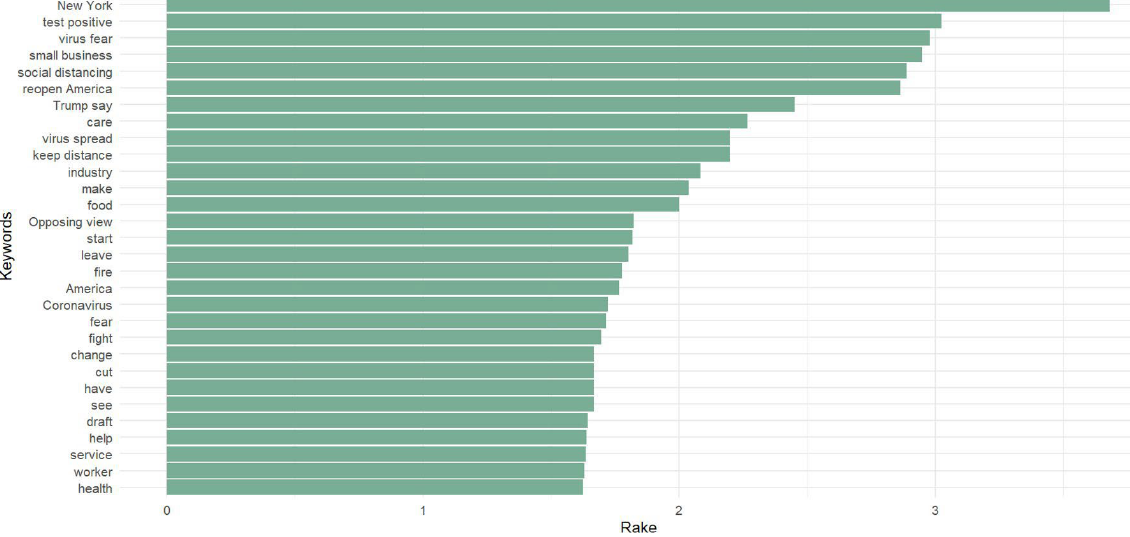
Figure 5. Keywords (noun, pronoun, verb, adjective) identified by RAKE (USA Today).